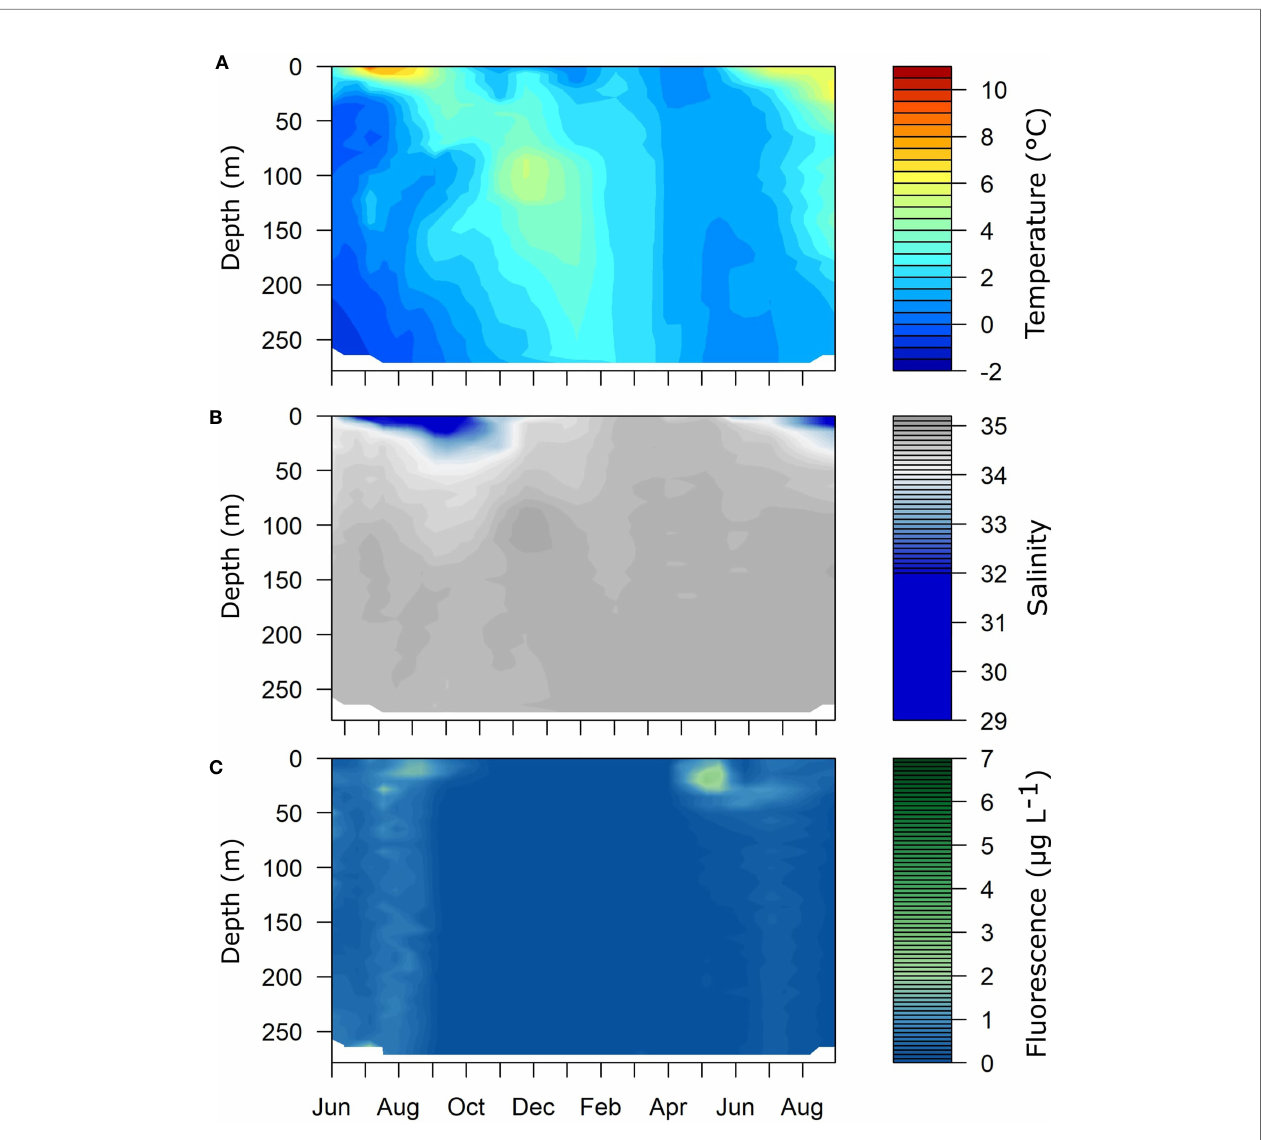
FIGURE 2 | Seasonal changes in (A) water temperature (°C), (B) salinity and (C) fl uorescence (µg L -1 ) in Isfjorden, station IsK, from June 2015 to August